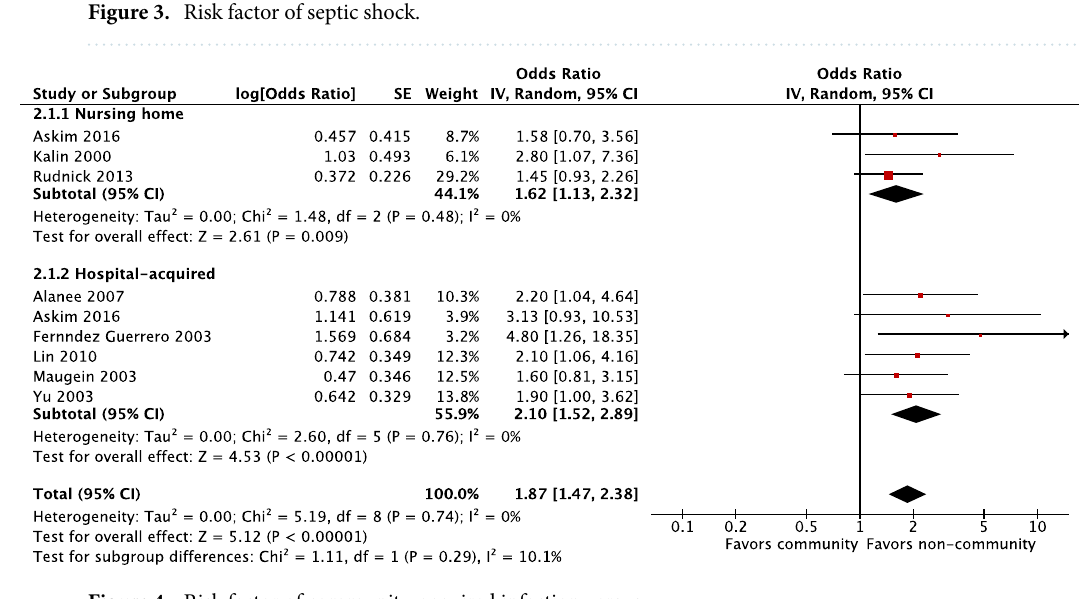
Figure 4. Risk factor of community-acquired infection